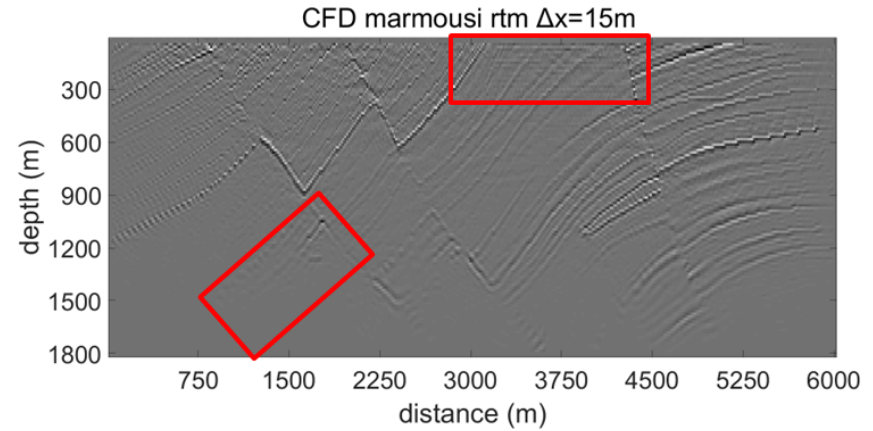
Figure 13. CFD is used for the reverse-time migration result with Marmousi shear-wave velocity model, Δ x = 15 m.